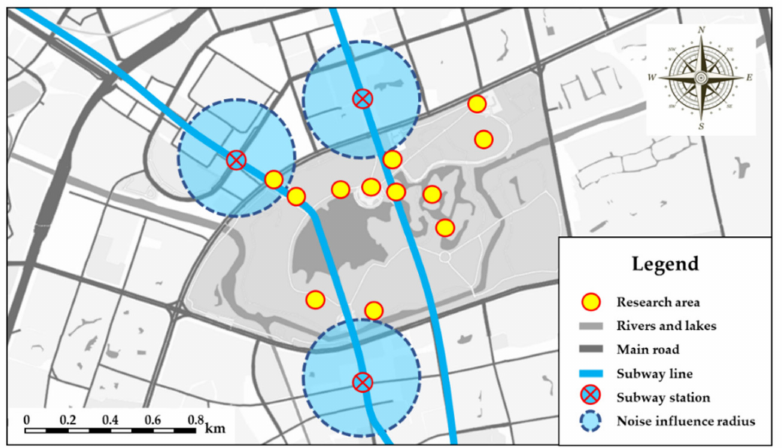
Figure 2. There are many traffic facilities and transportation hubs at the entrance and exit of Shanghai Century Park, resulting in various kind of artificial sounds. The figure was created by the